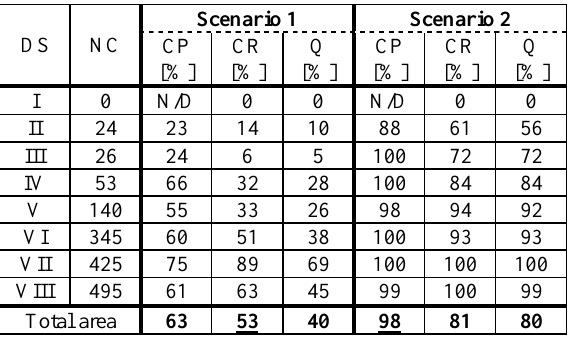
Table 4: Evaluation based on impact maps (N/D: not defined).